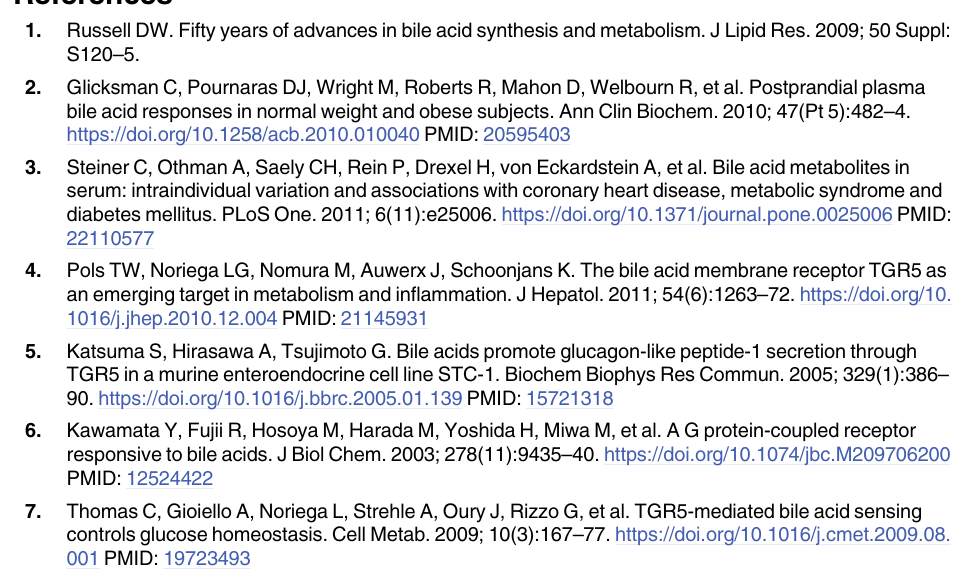
S1 Table. Primers for real-time RT-PCR analysis.